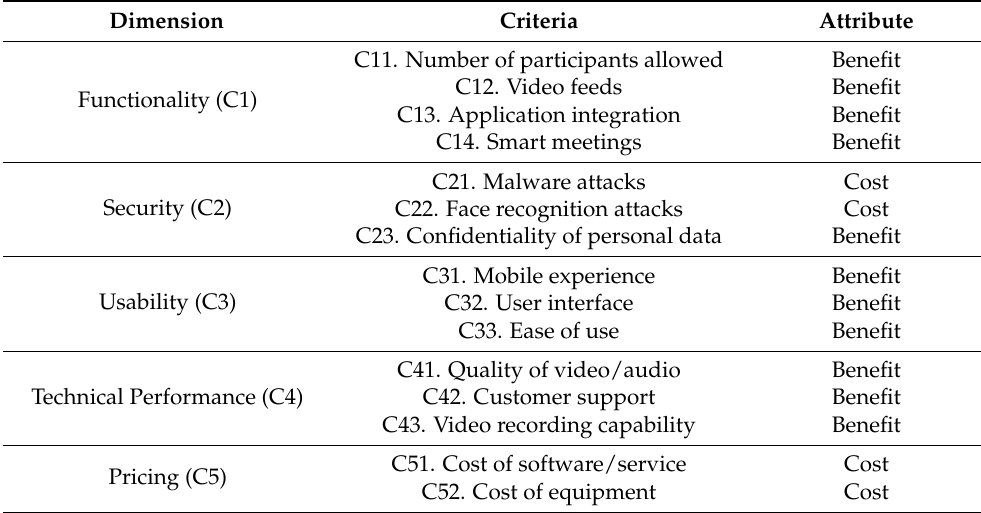
Table 4. The list of criteria used in this study.